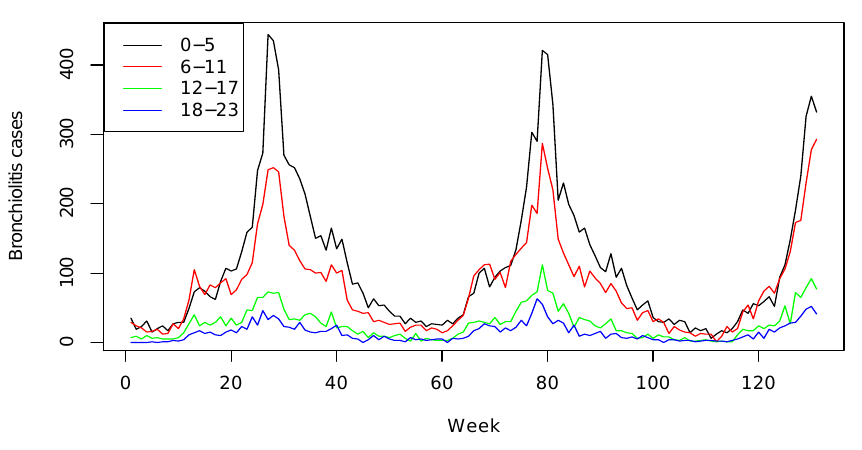
Figure 1. Weekly counts of bronchiolitis for the four age groups from July 2010 (week 28 June to 4 July) to December 2012 (week 24 December to 30